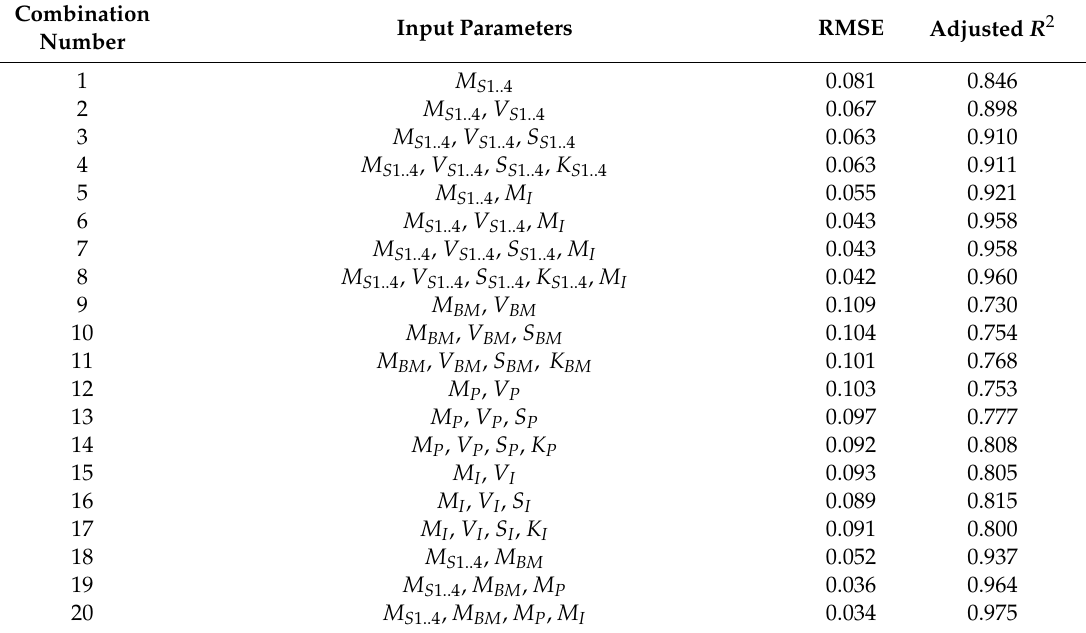
Table 3. Data for di ff erent combinations of input parameters for prediction of denoising e ffi ciency for